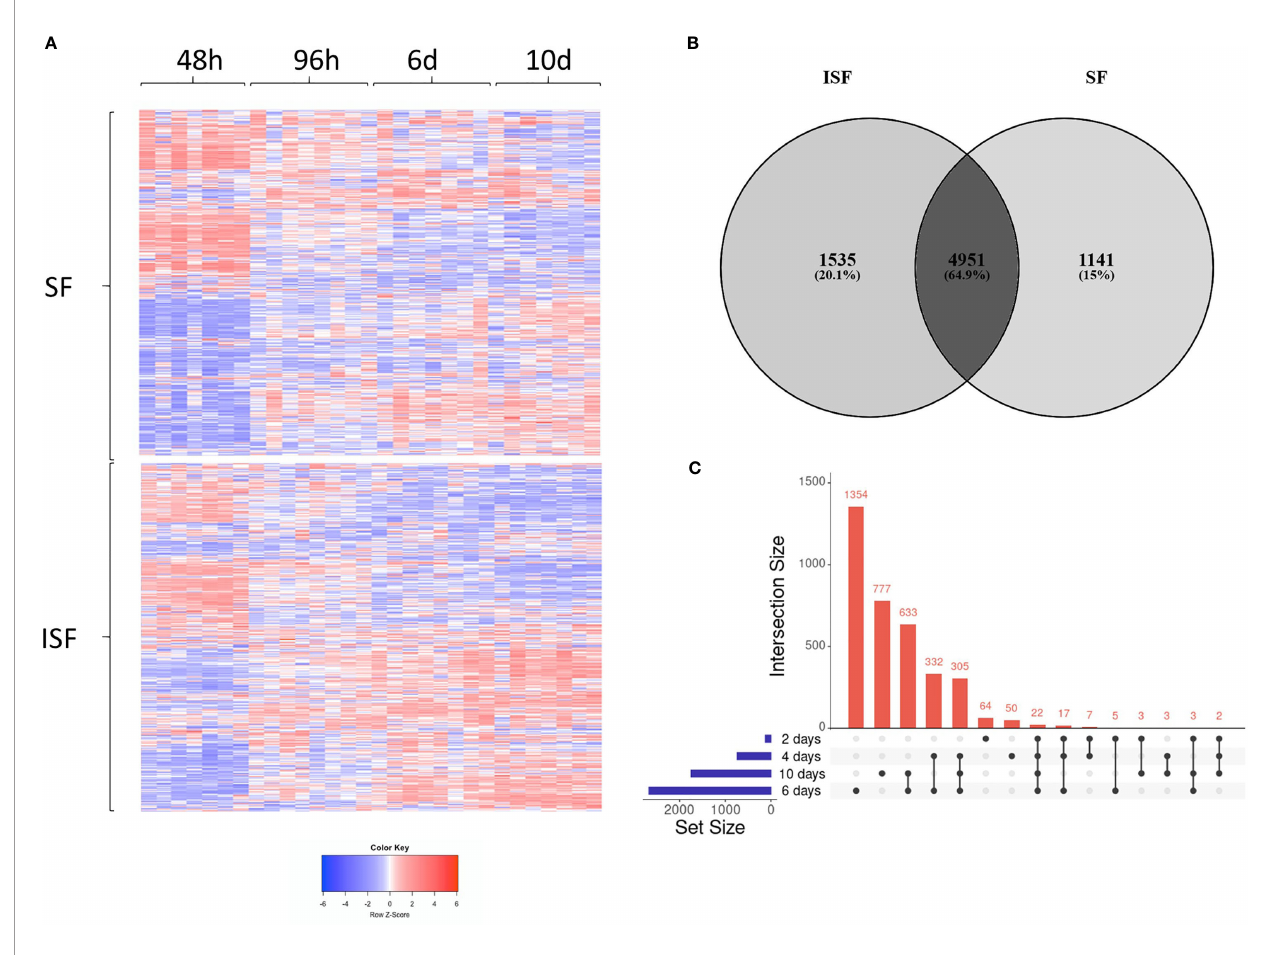
FIGURE 3 | Differentially expressed genes (DEGs) in BMNC cultured in normal (SF) and in fl amed autologous synovial fl uid (ISF). (A) Heatmap of DEGs (FDR<0.05) identi fi ed among all possible comparisons (n=8456) between SF and ISF cultures over 10 days. The heatmap was created using Log10 transformed GeTMM values expressed on a color scale denoting high (red) and low (blue) expression. Each dataset (SF and ISF) included all DEGs displayed in a fi xed position for comparison of the effect of culture medium over the same genes. (B) Venn diagram illustrating the intersection between DEGs identi fi ed by horizontal comparisons in either SF or ISF cultures. (C) Upset plots elucidating the intersection between DEGs identi fi ed by vertical comparisons. The nature of each intersection is indicated by the dots under the vertical bars, which denote the number of DEGs in each intersection, while horizontal bars represent the number of DEGs in each